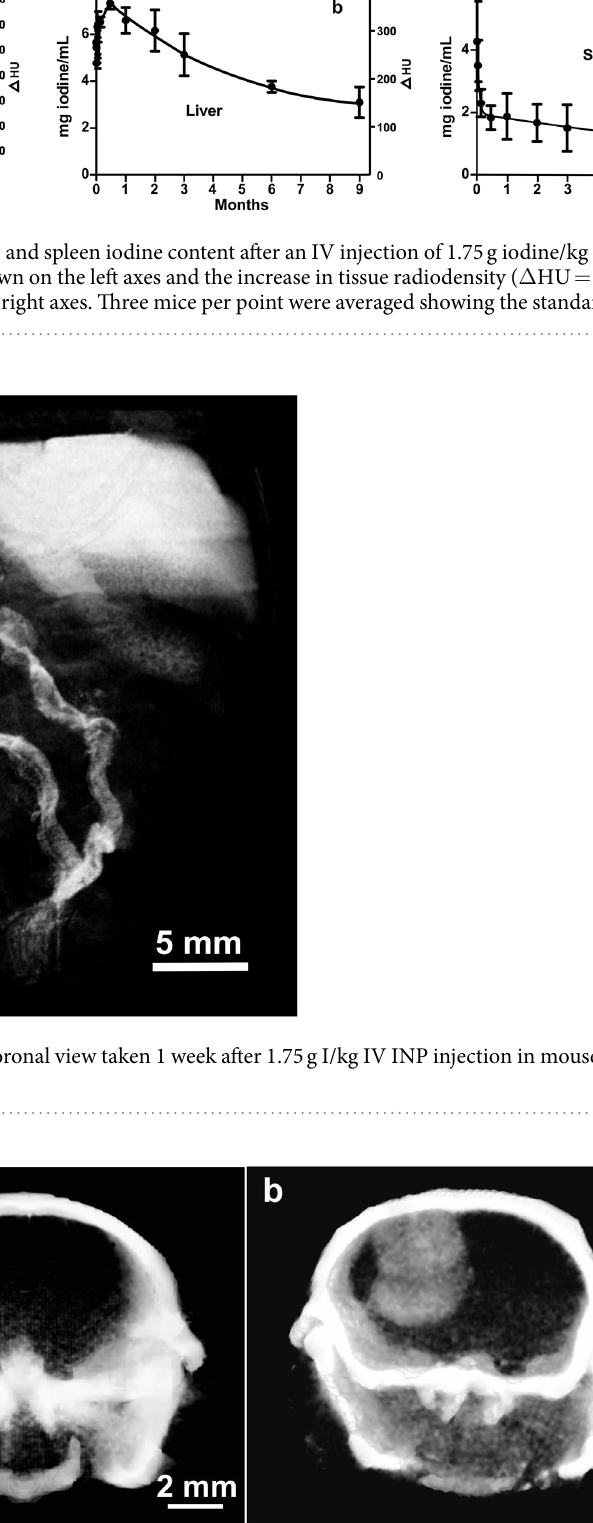
Figure 8. MicroCT 1.8 mm thick coronal mouse head sections taken ( a ): without iodine nanoparticles and ( b ): 24 hours after IV injection of 1.75 g iodine/kg